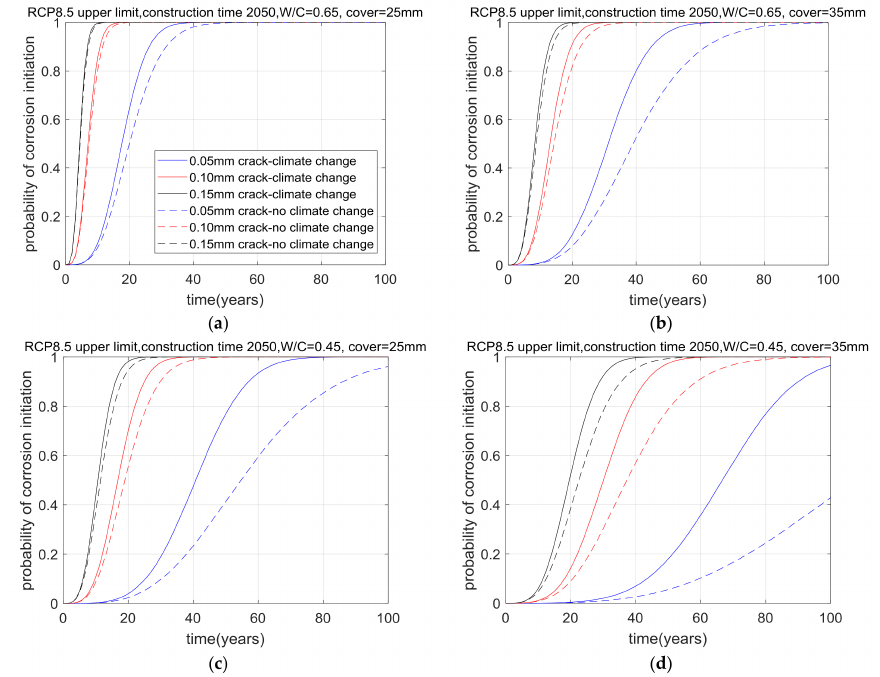
Figure 13. Probability of corrosion initiation-RCP 8.5 upper 90% confidence interval, time slice 2050. ( a ) W/C: 0.65, Cover depth: 25 mm; ( b ) W/C: 0.65, Cover depth: 35 mm; ( c ) W/C: 0.45, Cover depth: 25 mm; ( d ) W/C: 0.45, Cover depth: 35